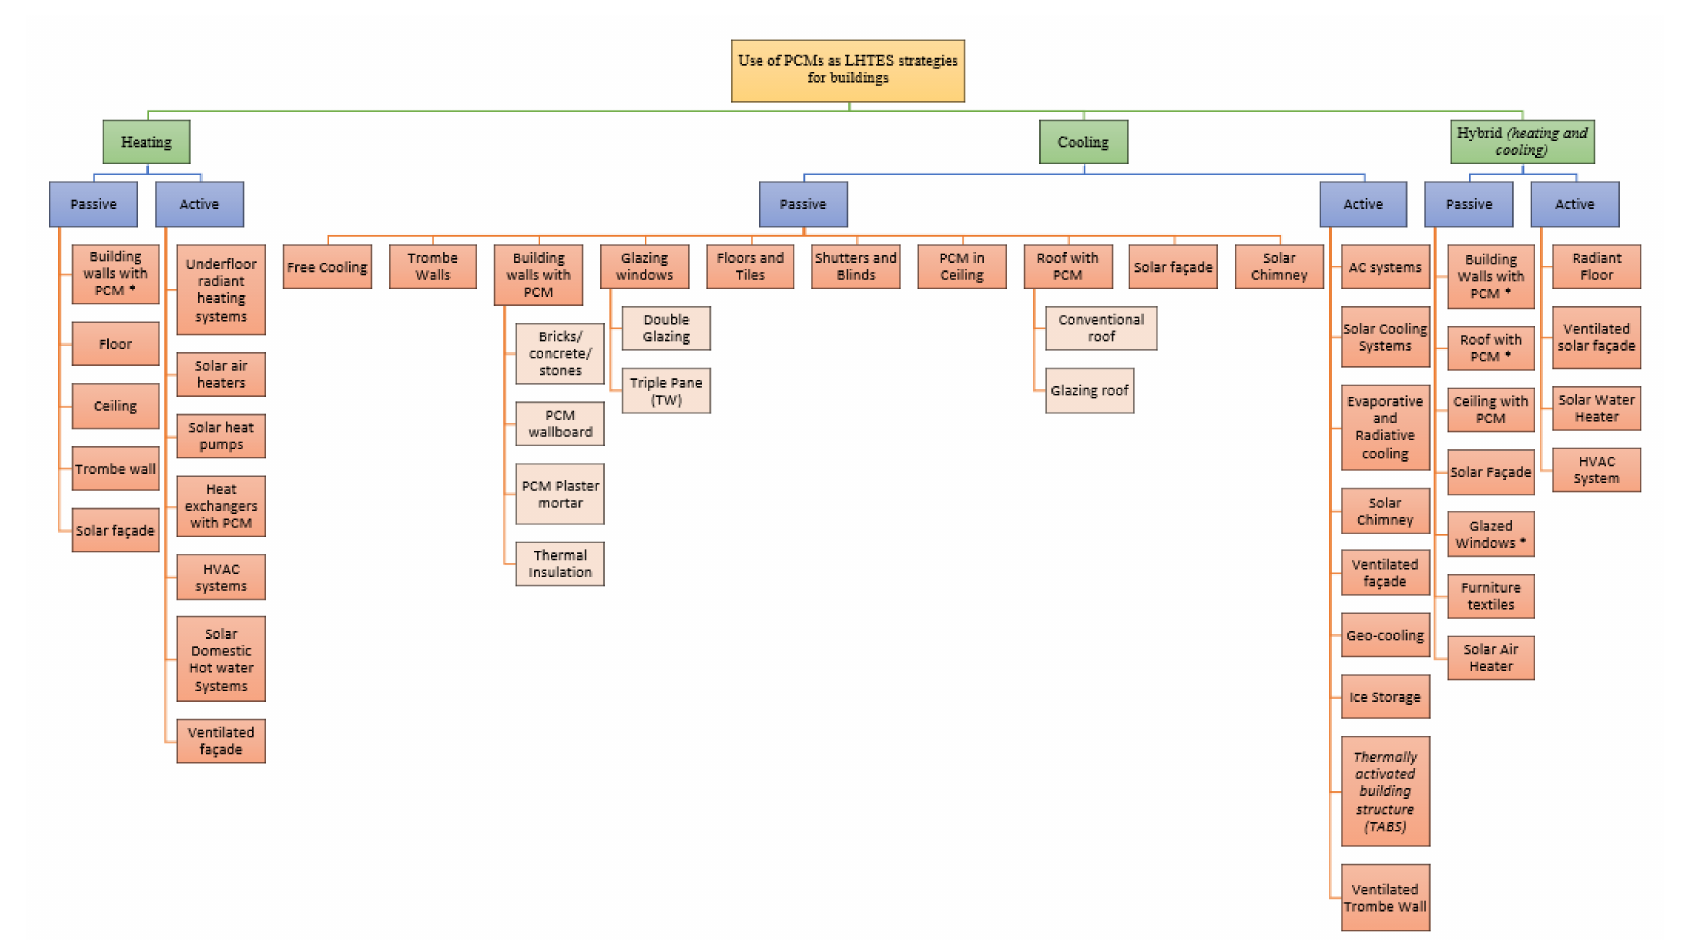
Figure 13. Summary of heating, cooling, and hybrid PCM applications in buildings